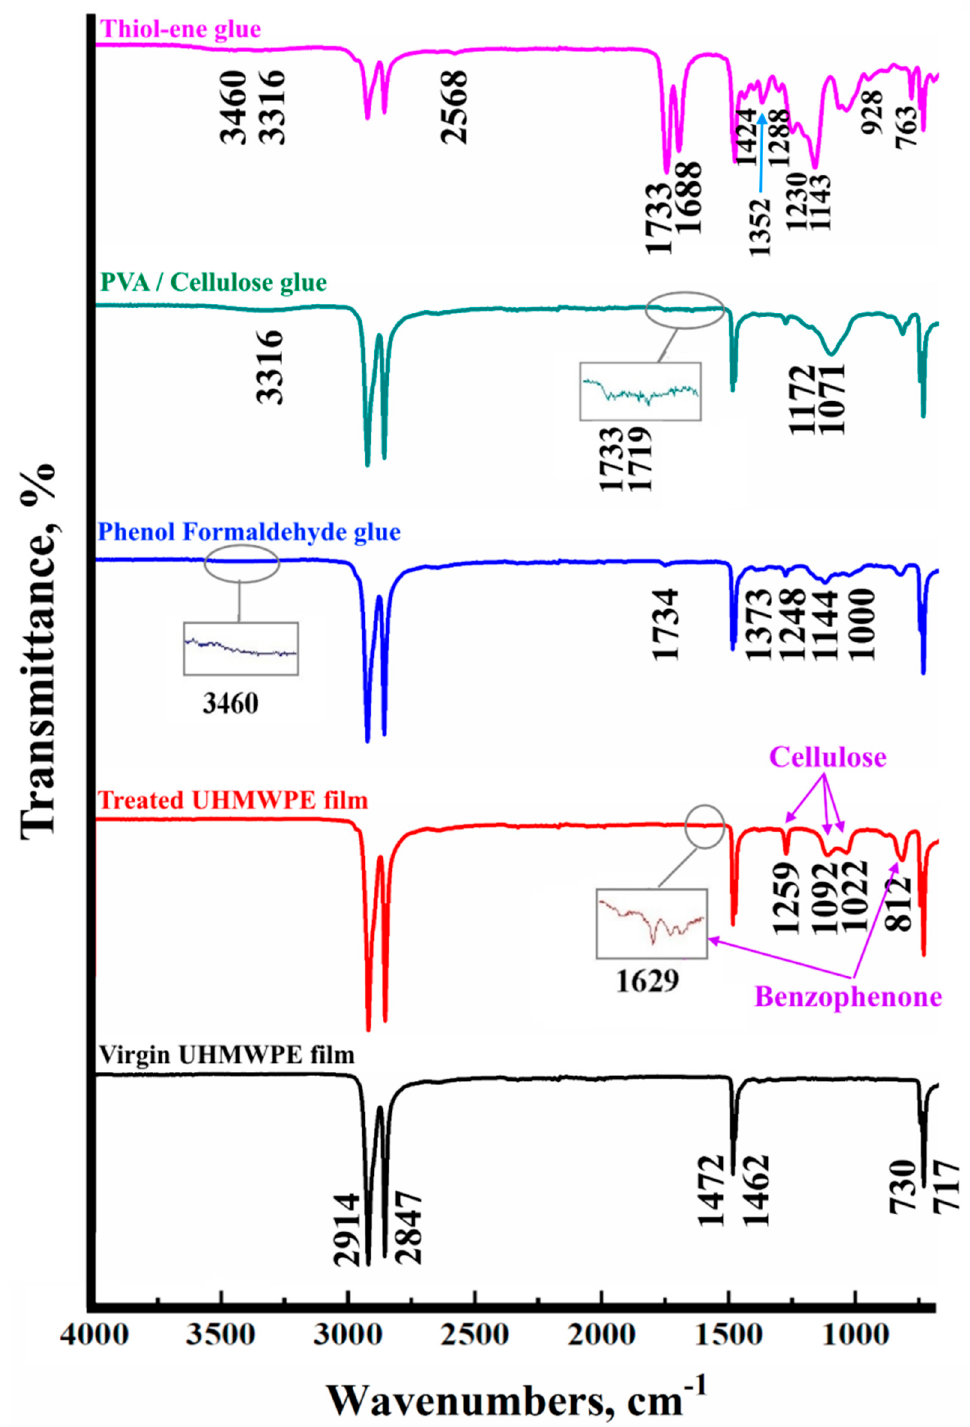
Figure 6. The FT-IR spectra of the virgin UHMWPE film, treated UHMWPE film by cellulose grafting and treated UHMWPE films glued by glues based on thiol-ene reaction, PVA/Cellulose and phenol formaldehyde.